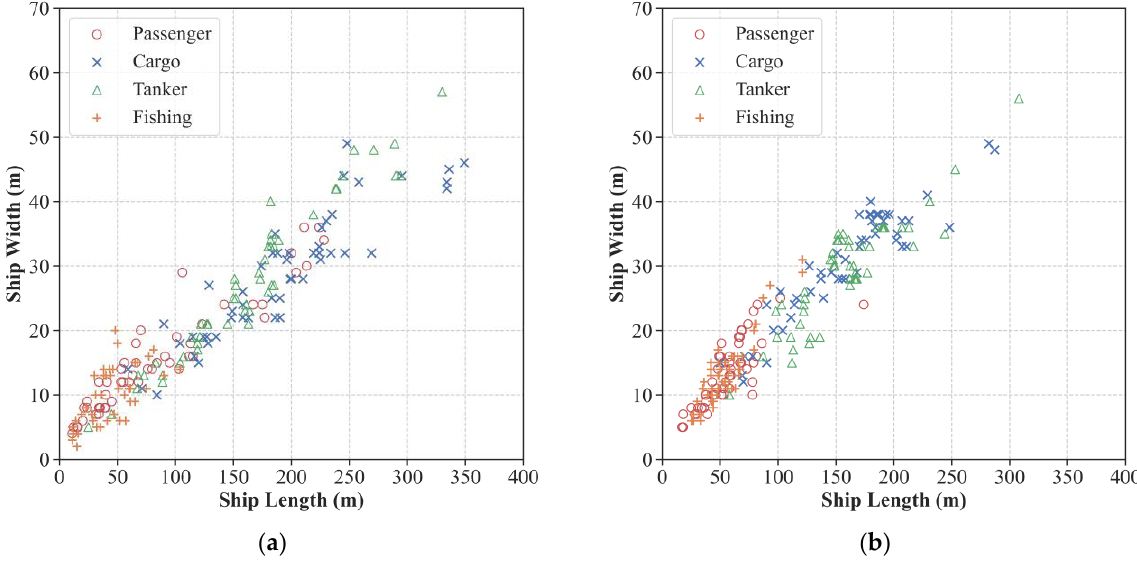
Figure 6. The length and width distribution of various types of ships in AIS data and SAR images. ( a ) AIS data ship size distribution and ( b ) SAR image ship size distribution.